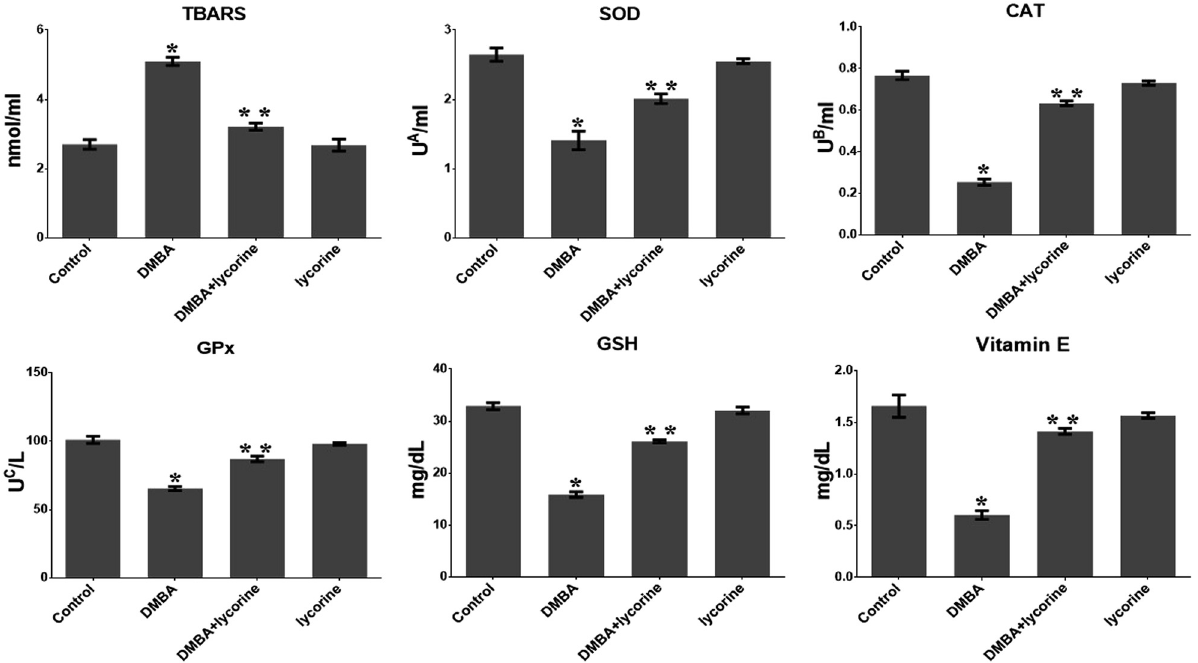
Figure2: EffectoflycorineonTBARSandantioxidantsinplasmaofallexperimentalhamsters.(A)Thevolumeofenzymeneededtoinhibit50% NBT reduction, (B) Micromoles of hydrogen peroxide utilized/second, (C) Micromoles of glutathione utilized/minute. Values are shown as mean ± SD (n=6). *p<0.05, **p<0.01 vs. control